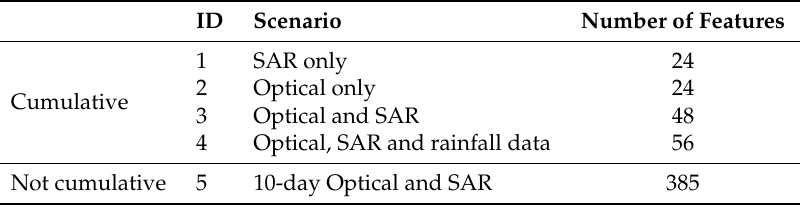
Table 4. Summary of the different scenarios tested, with the number of features over the period from April to